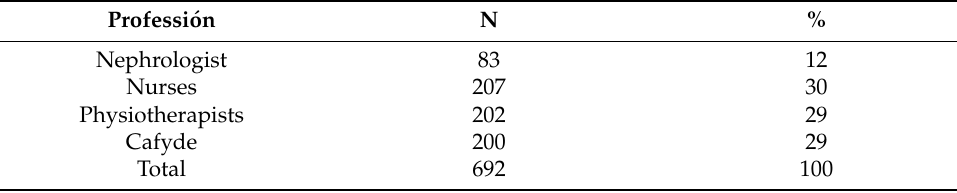
Table 1. Distribution of study participants according to their